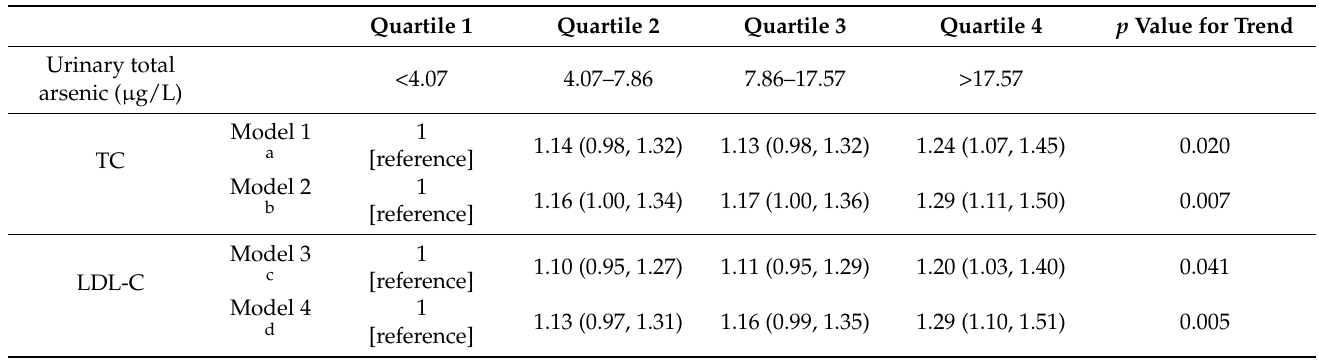
Table 4. Odds ratios of TC and LDL-C by quartiles of urine arsenic concentrations.